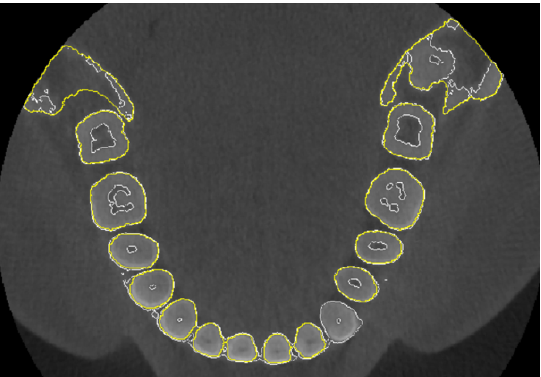
Figure 4. User-specified ROI from a patient-specific CT scan. Gray lines indicate the regions recognized by the software from a pre-set threshold value. Yellow lines indicate user-specified ROI (a canine was ex- tracted as a dental implant was placed in its stead.